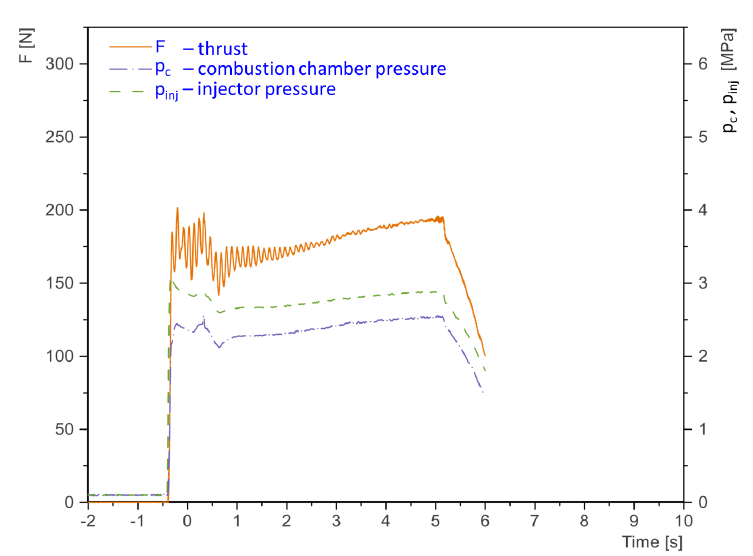
Figure 16. Test data of an engine test with a burn time of 5 s and star